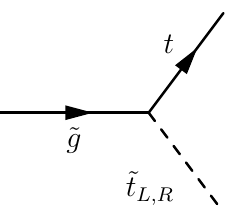
Figure 9. Decay of a gluino into a stop and a top